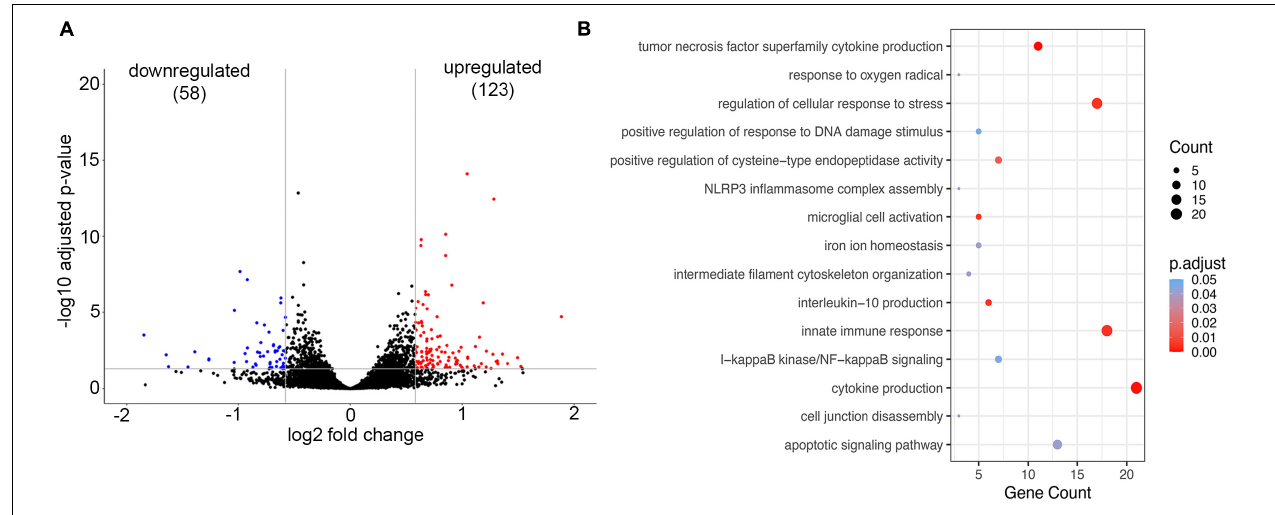
FIGURE 4 | Analysis of Gene expression in isolated microvessels of Tg-SwDI (6 months) and control (6 months). (A) Volcano plot represents differential expressed genes (DEGs). The x - and y -axes show log2 fold change and − log10 p -value, respectively. Red points are upregulated genes, blue points are downregulated genes, and black points are genes with no significant difference. (B) The scatter plot of GO-based overrepresentation analysis results of DEGs in Tg-SwDI (6 months). The y -axis shows significantly ( p < 0.05) overrepresented GO terms. The x -axis shows the gene count number of genes enriched in each GO